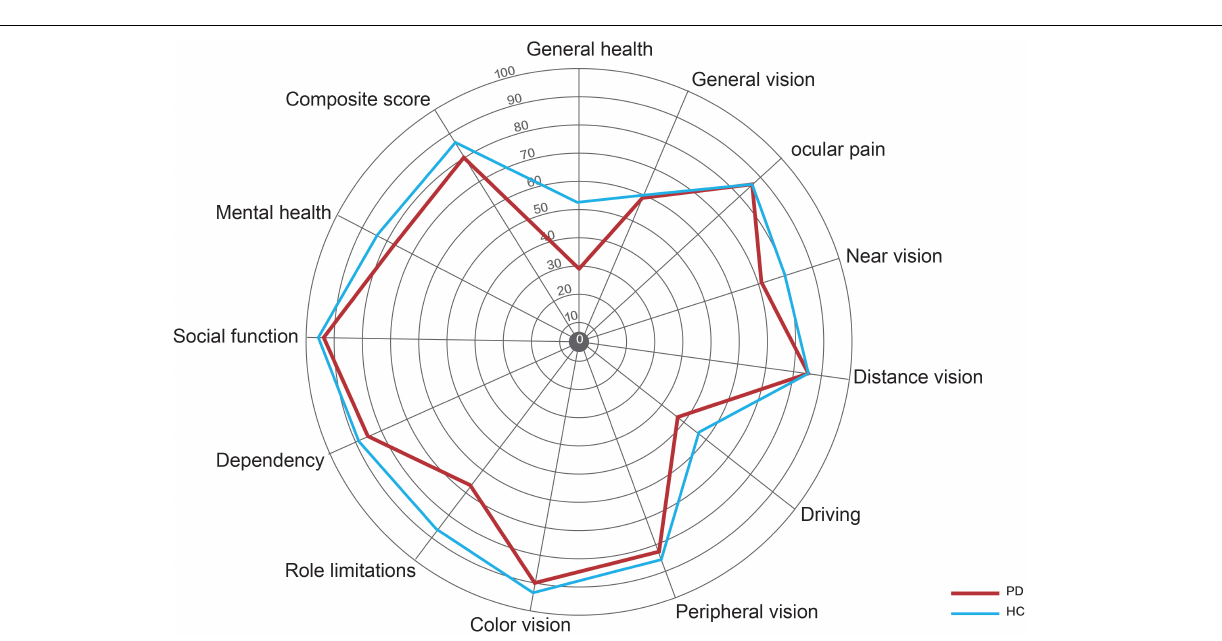
area (0.720), inner ring (0.716), nasal sector (0.678), superior sector (0.668), inferior sector (0.668), and central sector (0.655) ( Figure 4